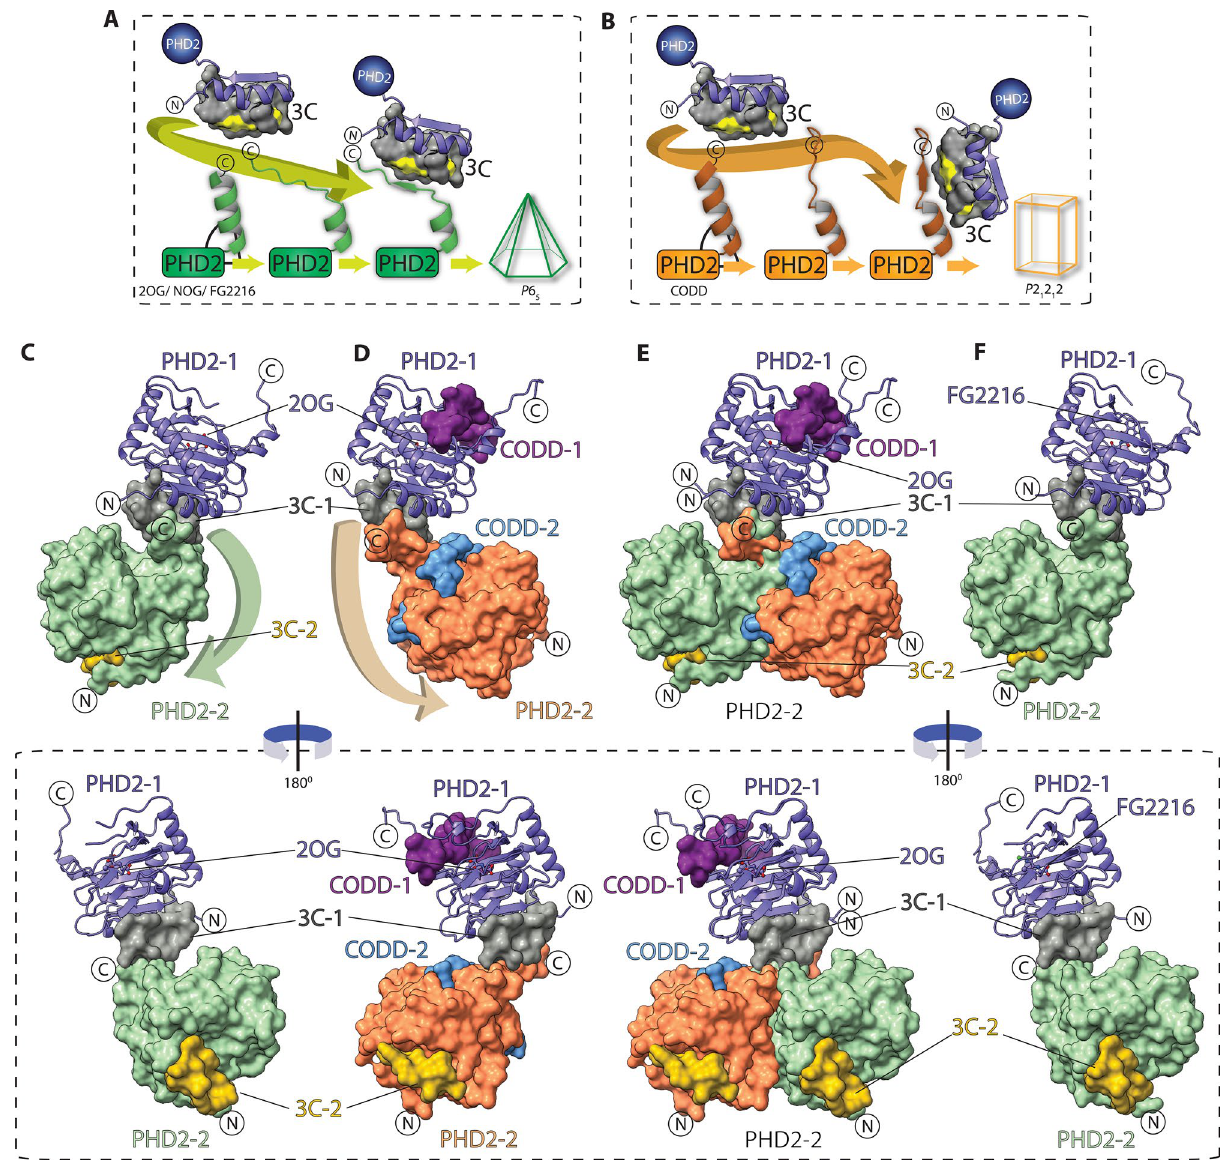
Figure 5. Overview of 3C induced crystal packing in various PHD2 complexes. The figure outlines a proposed scheme of how 3C recognizes different PHD2 C -terminal conformations and consequently induces crystallization in different forms. ( A ) and ( B ) show the PHD2 C -terminus (green and blue cartoons) as observed in 3C-unbound (starting point) and 3C-bound (end point) states in PHD2 structures with 2OG/ NOG/FG2216 ( A ) vs. CODD ( B ). In all 3C-unbound structures, the C -terminal residues 393–403 form part of α4; in the cPHD2.3C complexes, α4 only extends to residue 397 before its helicity is broken; this is precisely the point at which 3C interacts with a symmetry-related molecule inducing formation of an extended anti-parallel β-sheet (see Fig. 3). ( C – F ) show views from structures of cPHD2.2OG.3C ( C ), cPHD2.2OG.CODD.3C ( D ), superimposed PHD2.2OG.3C and PHD2.2OG.CODD.3C ( E ), and cPHD2.FG2216.3C complexes ( F ) and their corresponding 180° rotated views in a dotted box (bottom panel). Note that when comparing nPHD2.2OG/ inhibitor (2OG/PDB: 3OUJ, NOG/PDB: 5L9R, and FG2216/PDB: 4BQX), and nPHD2.CODD (PDB ID: 5L9B) structures, in the latter case, α4 interacts with CODD and moves towards the DSBH core. Thus there